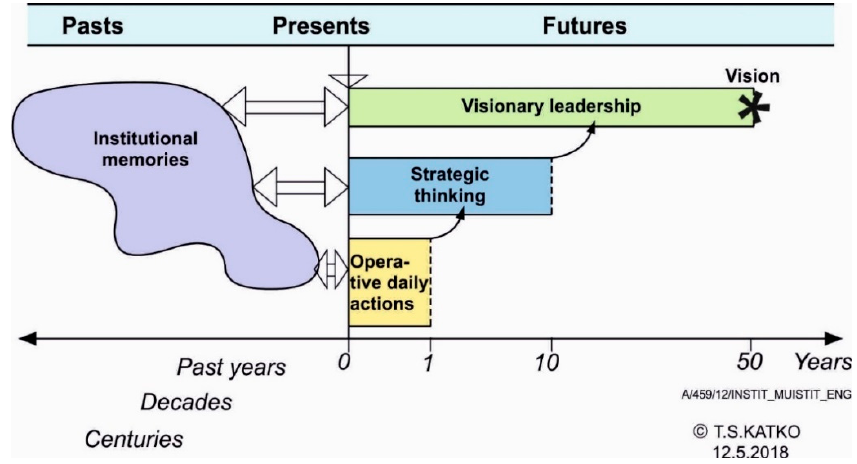
Figure 1. Relationships between the pasts, presents and futures and the timeframe for futures thinking and leadership: From operational to strategic and visionary thinking [13] (p. 253).